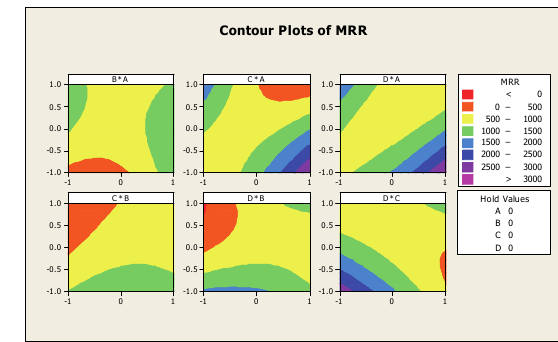
Fig. 8. Normal probability plots of MRR Fig. 9. Contour plots of